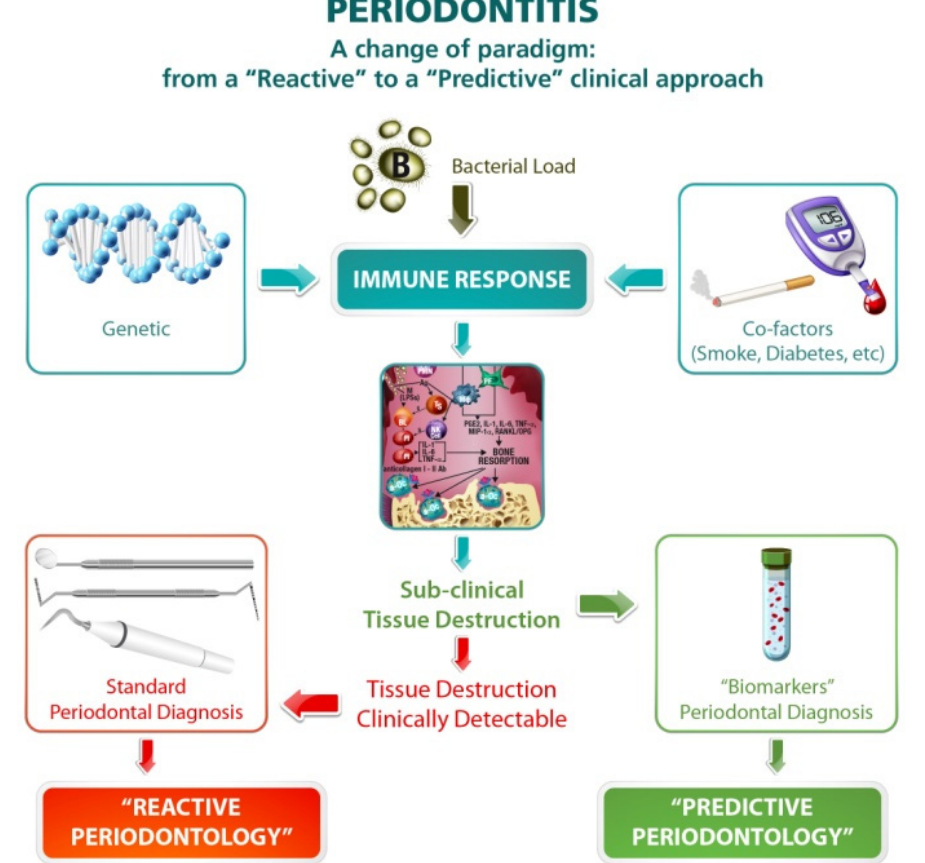
Figure 3. A change of paradigm in periodontal diagnosis is desirable. A shift from a “Reactive“ approach, in which clinicians react to the presence of clinically evident periodontal damage, towards a “Predictive” approach, in which the disease is intercepted early when it is already in a sub-clinical phase, is the new objective in periodontal diagnosis.